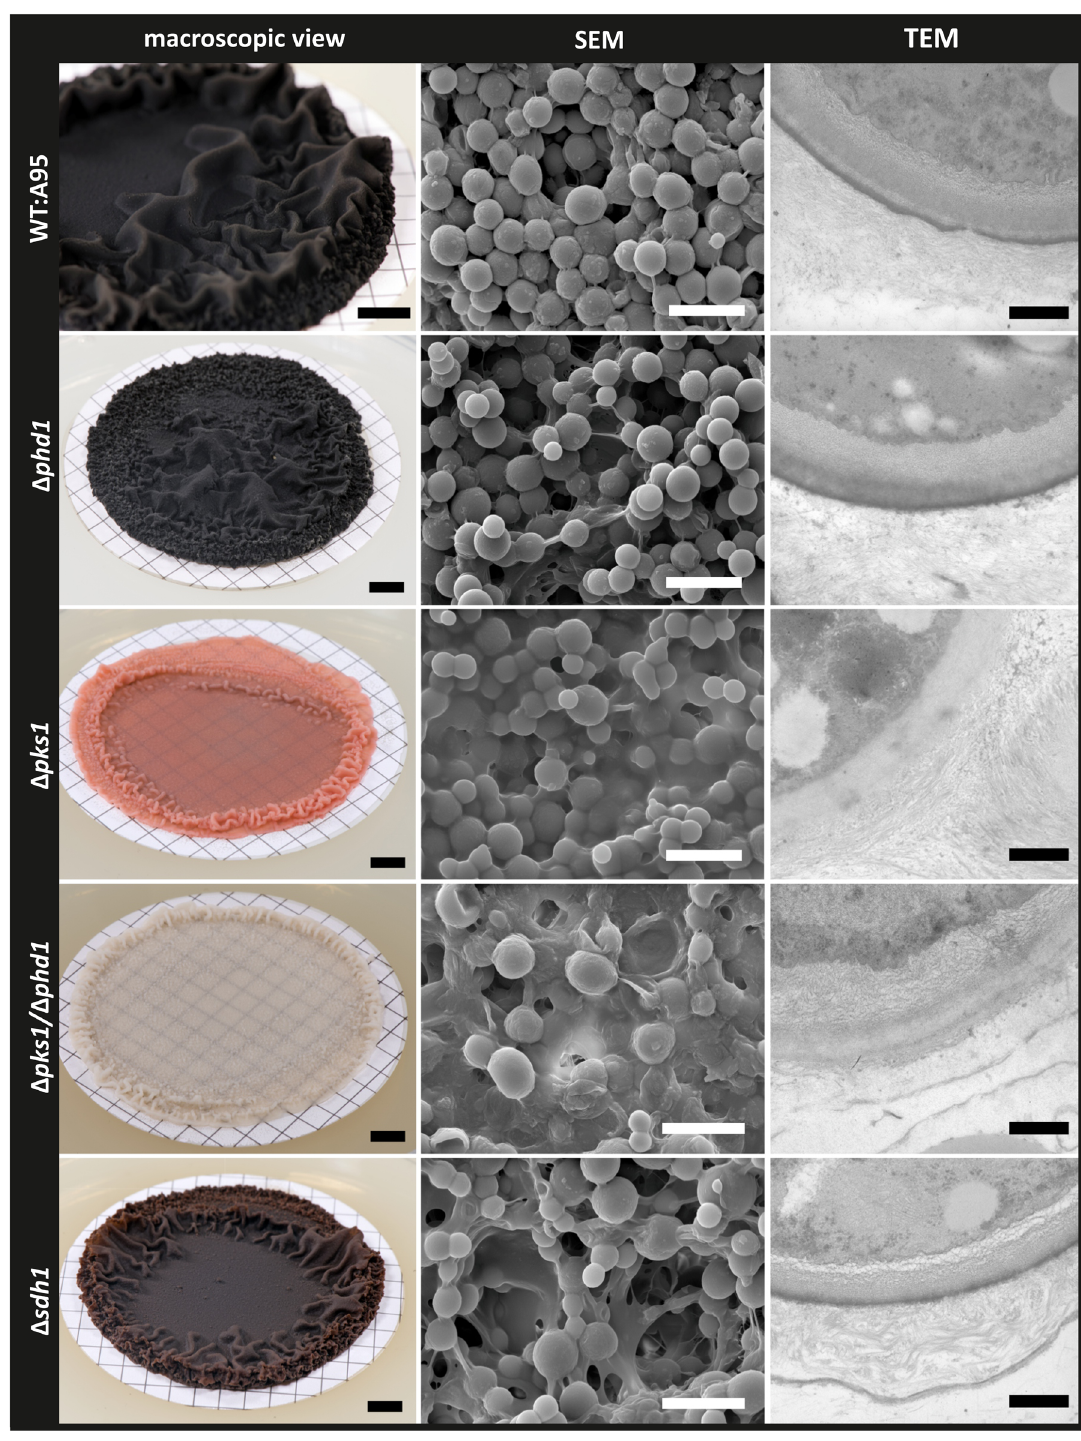
Fig. 1 Imaging of K. petricola WT and pigment mutant bio fi lms. Macroscopic photographs show the morphology of the fungal bio fi lms. Cryo-scanning electron microscopy (cryo-SEM) and transmission electron microscopy (TEM) imaging show a close-up view of the bio fi lms and cell walls with EPS of single cells. Scale bar in macroscopic photographs = 5 mm; in SEM pictures = 20 µm and in TEM pictures = 500